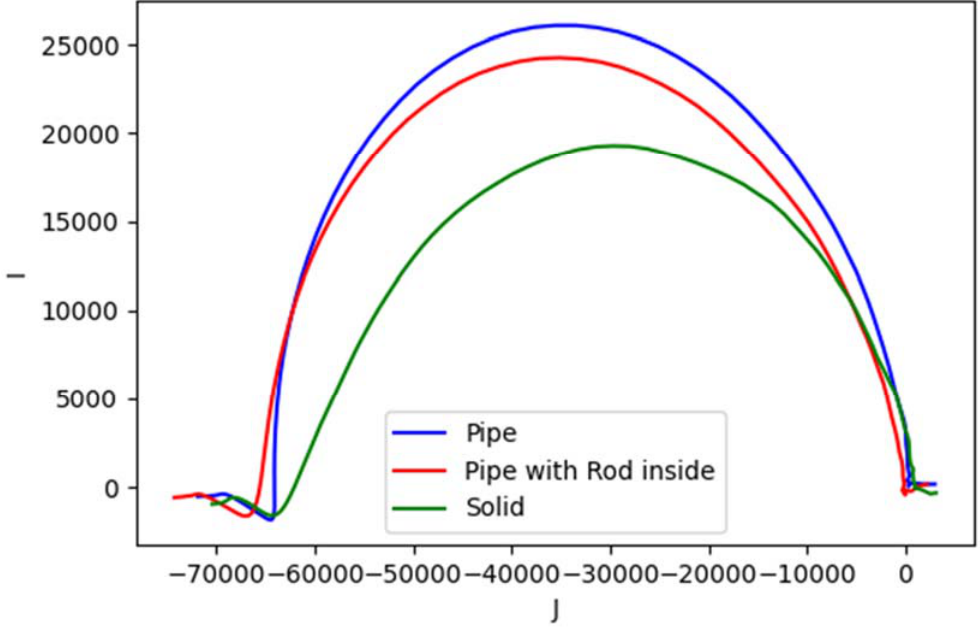
Figure 24. Complex plot of impedance for metallic structures.